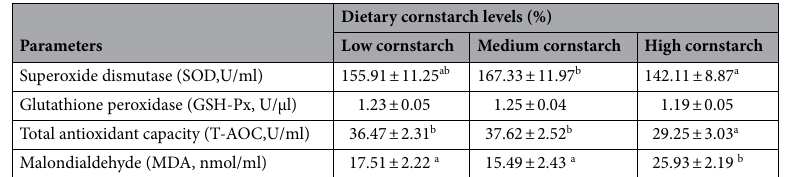
Table 5. Antioxidant-related parameters of GIFT tilapia fed test diets*. *Data represented as mean ± SD of four replicate tanks. Values in the same row with different superscripts are significantly different ( P < 0.05).